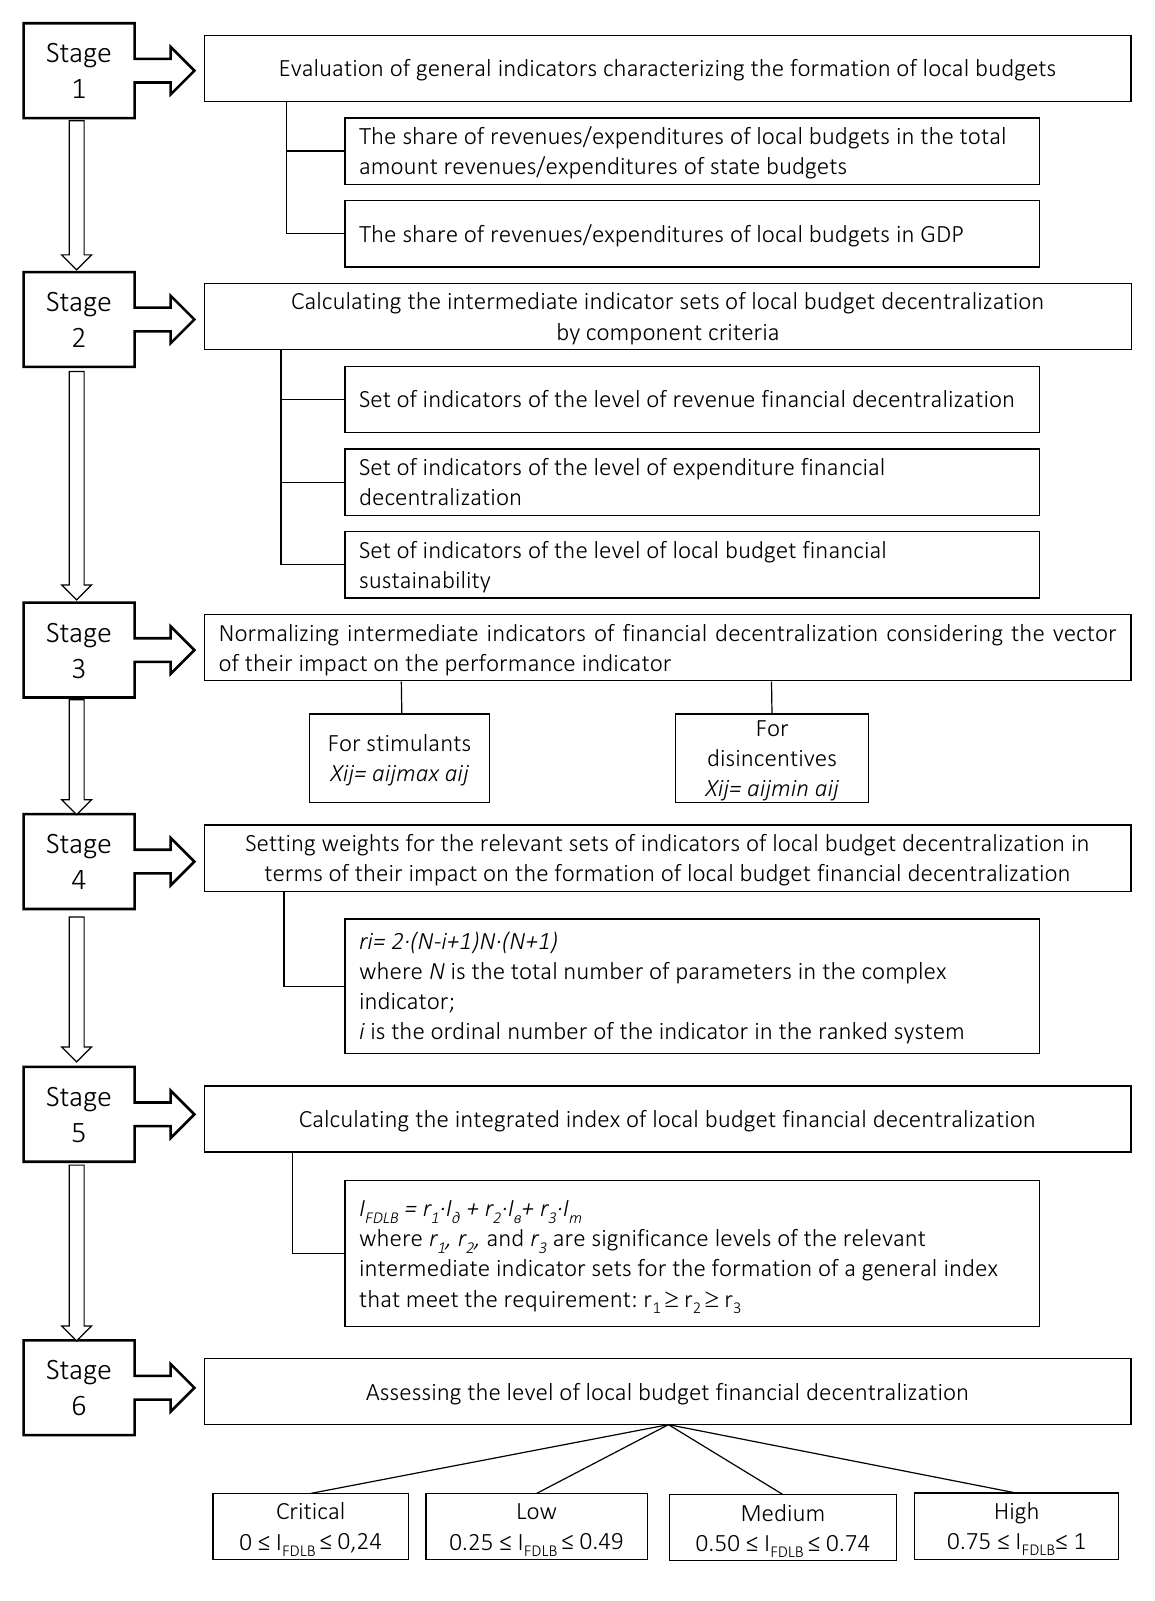
Figure 2. Algorithm for determining the level of local budget financial